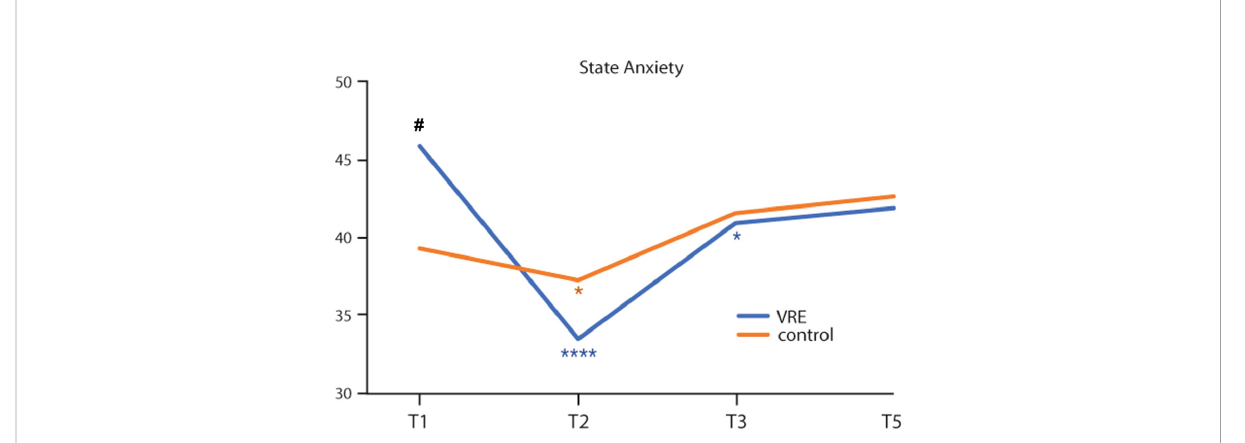
FIGURE 1 State anxiety mean values from the start to 48 hours from the end of the fi rst chemotherapy cycle in the two study arms. *Intra-group variability. #Inter-group variability. Statistical signi fi cance: * ,# p < 0.05; ****p <